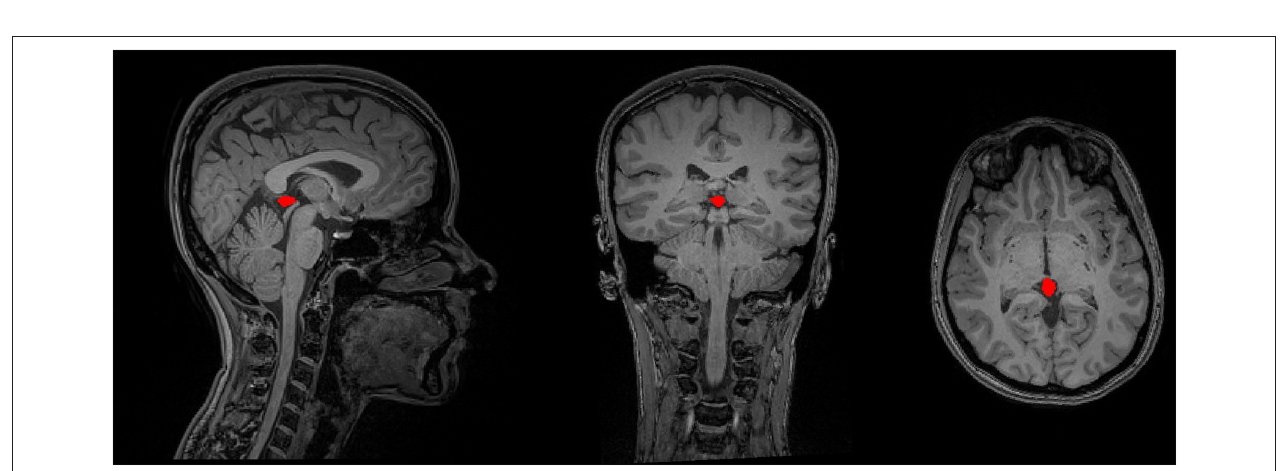
FIGURE 2 | The delineation of the PG’s contour on a sample T1-weighted MRI data in the sagittal, coronal, and axial image views.